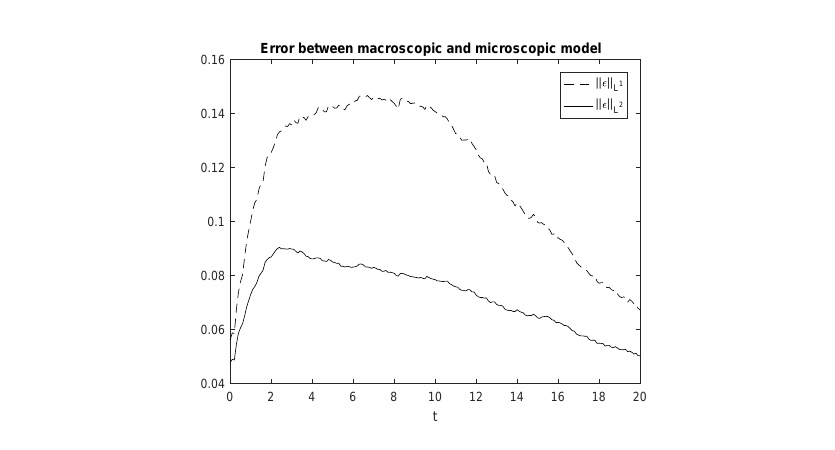
Figure 5: Mass balances at x = − 1 and x = 0